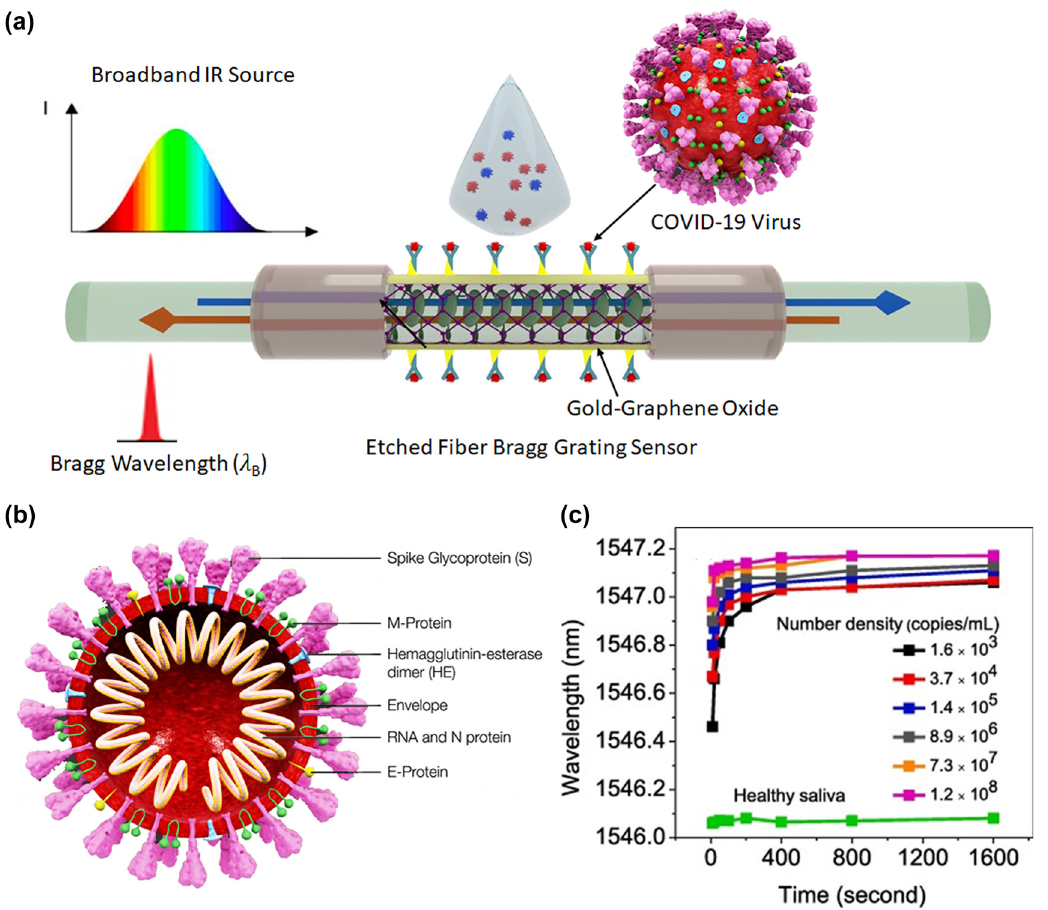
Figure 5: Illustration of the Fiber Bragg Grating (FBG) technique for virus detection. (a) Schematic diagram of the sensing mechanism of etched Fiber Bragg Gratings (EFBG), in which binding of the spike glycoprotein of COVID-19 virus with activated gold/graphene oxide (GO) nanolayer causes a shift in the Bragg wavelength. (b) Schematic diagram of COVID-19 virus with four structural proteins and single-stranded RNA [73]. (c) The wavelength of the detected light after passing through the fiber probe versus exposure time for various virus concentrations. Healthy saliva’s data can be considered as reference, and the amount of deviation from that indicates infection level of the patient. Adapted with permission from ref. [72]. Copyright [2020]